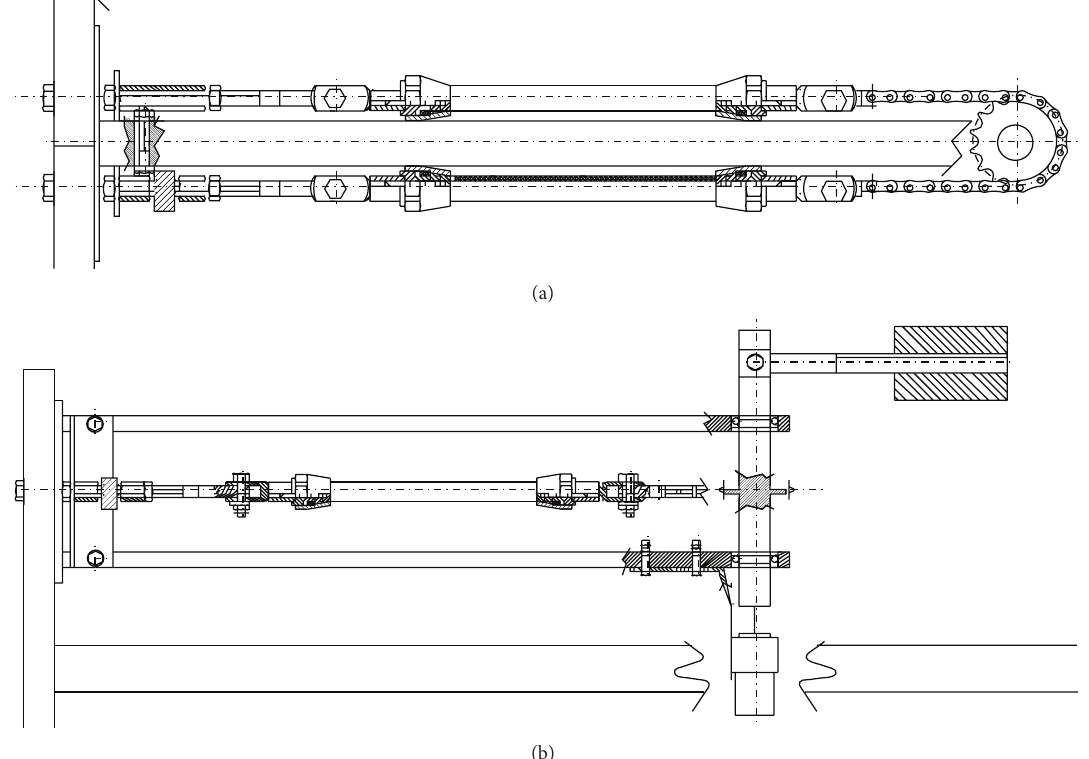
Figure 1: Mechanical configuration of pneumatic muscle actuator with two muscles in antagonistic connection joined through a chain gear ((a) front view and (b) side view).